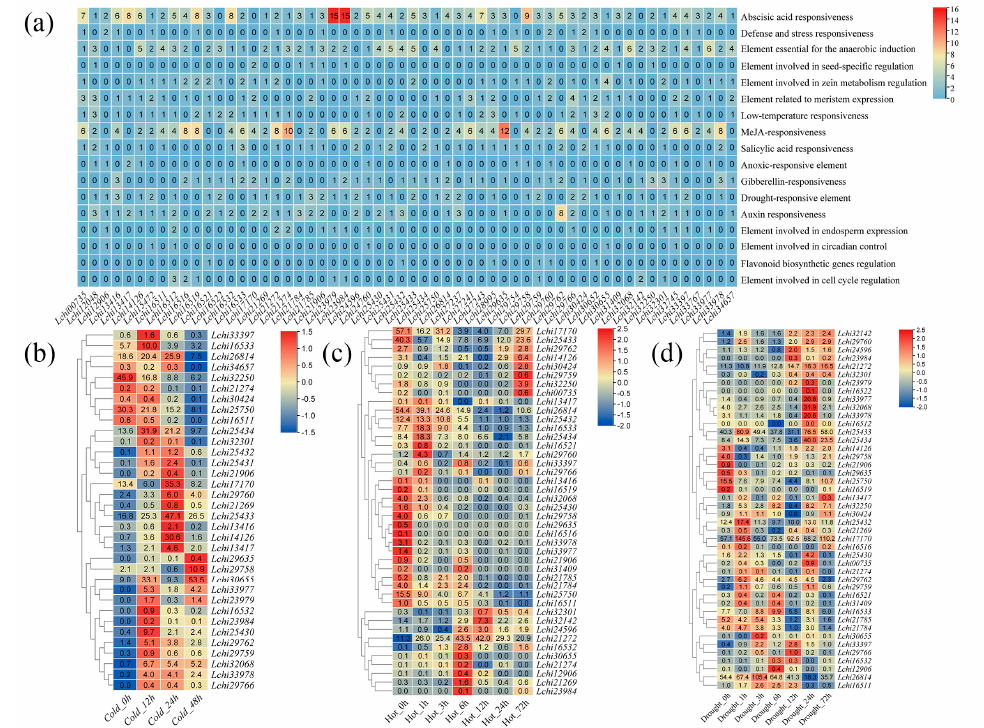
Figure 4. A cis-acting element analysis and the transcriptional responses of TPS genes in L. chinense . ( a ) The cis-acting elements were identified in the promoter regions of the LcTPS genes. The gradient color from blue to red, and the numbers in the grid, indicate the number of di ff erent cis-acting elements in LcTPSs . The transcription levels of LcTPS genes under low temperature ( b ), high temperature ( c ), and drought stress ( d ). The expression levels of the genes were represented by transcripts per million (TPM). The raw data of relative expression values and standard errors are provided in Table S3.